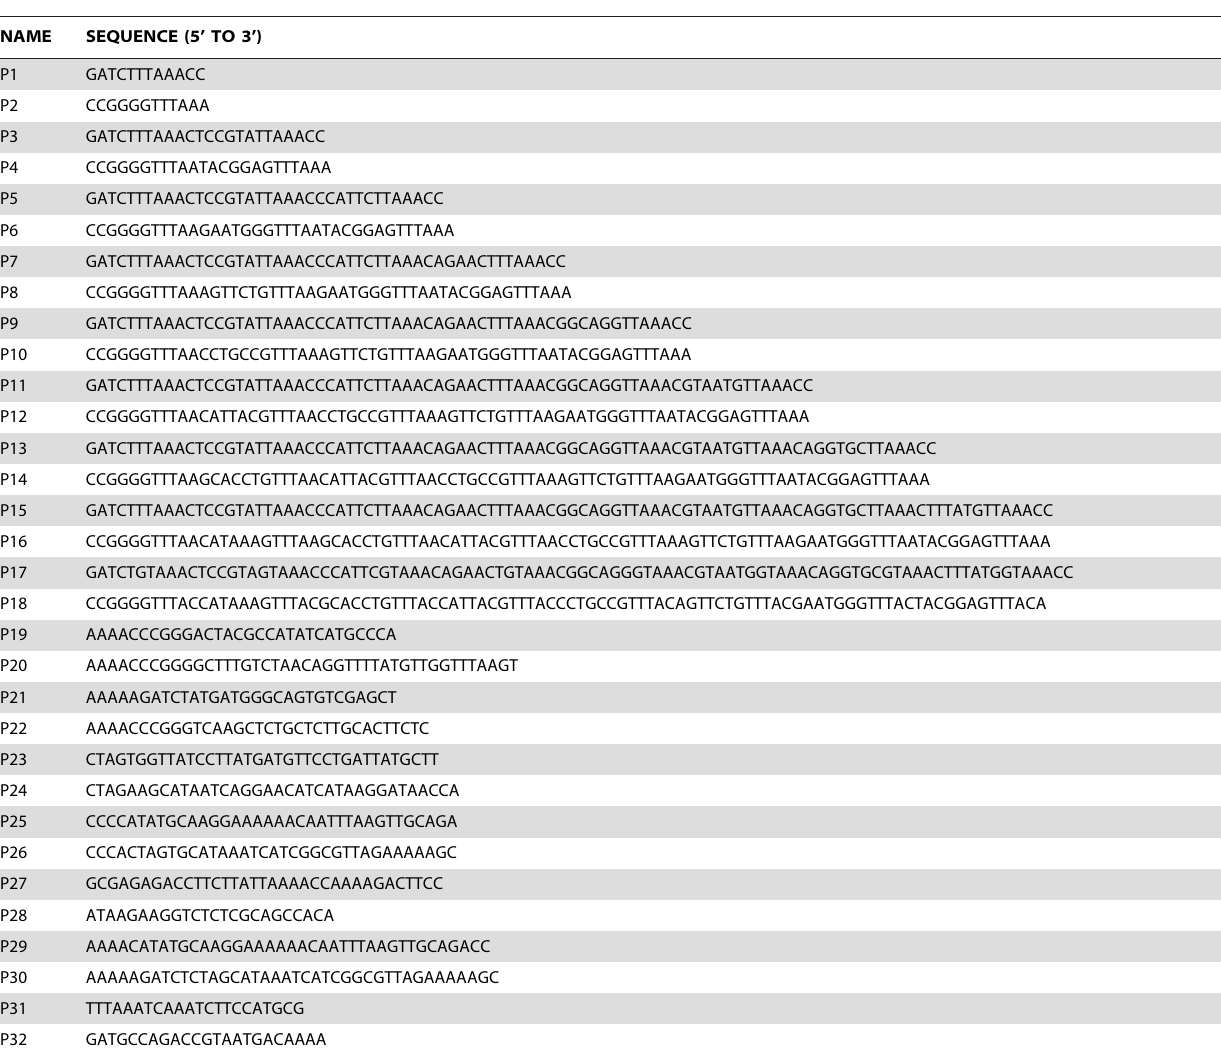
Table 2. Primers used in this